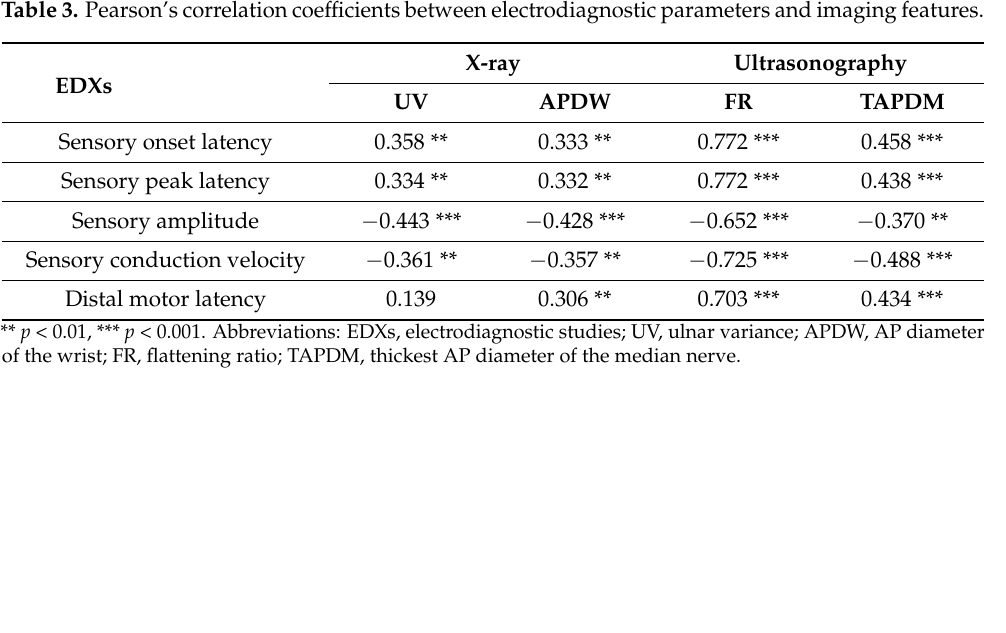
Values are presented as the mean ± standard deviation. Abbreviation: CTS, carpal tunnel syndrome.